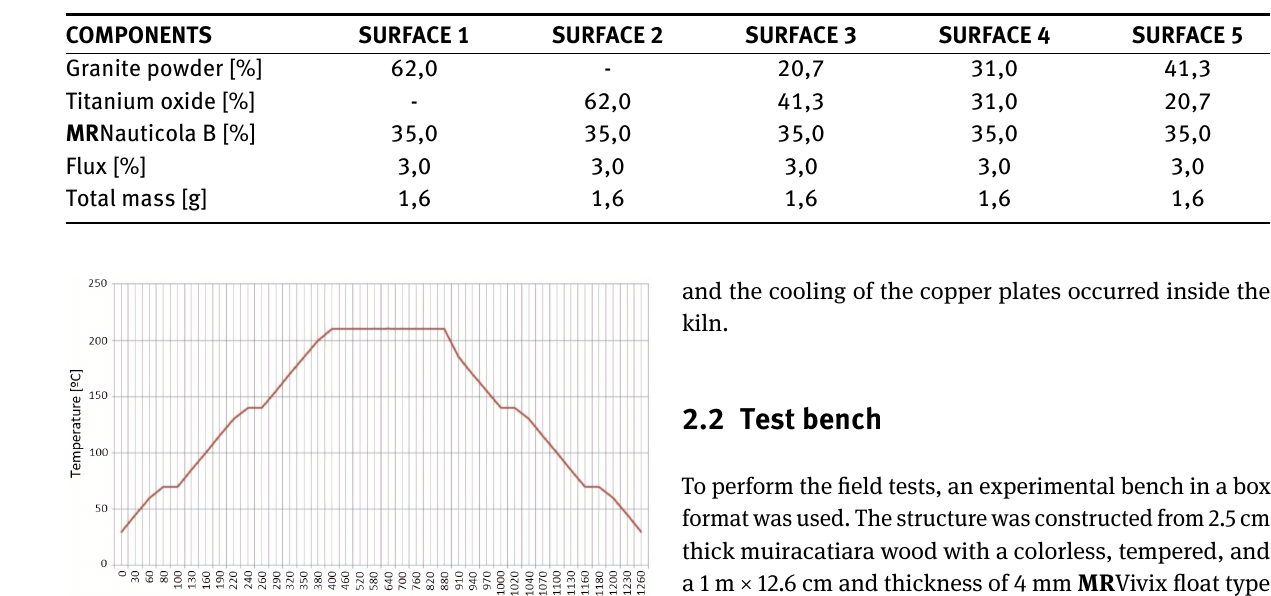
Table 1: Composition of selective surfaces.